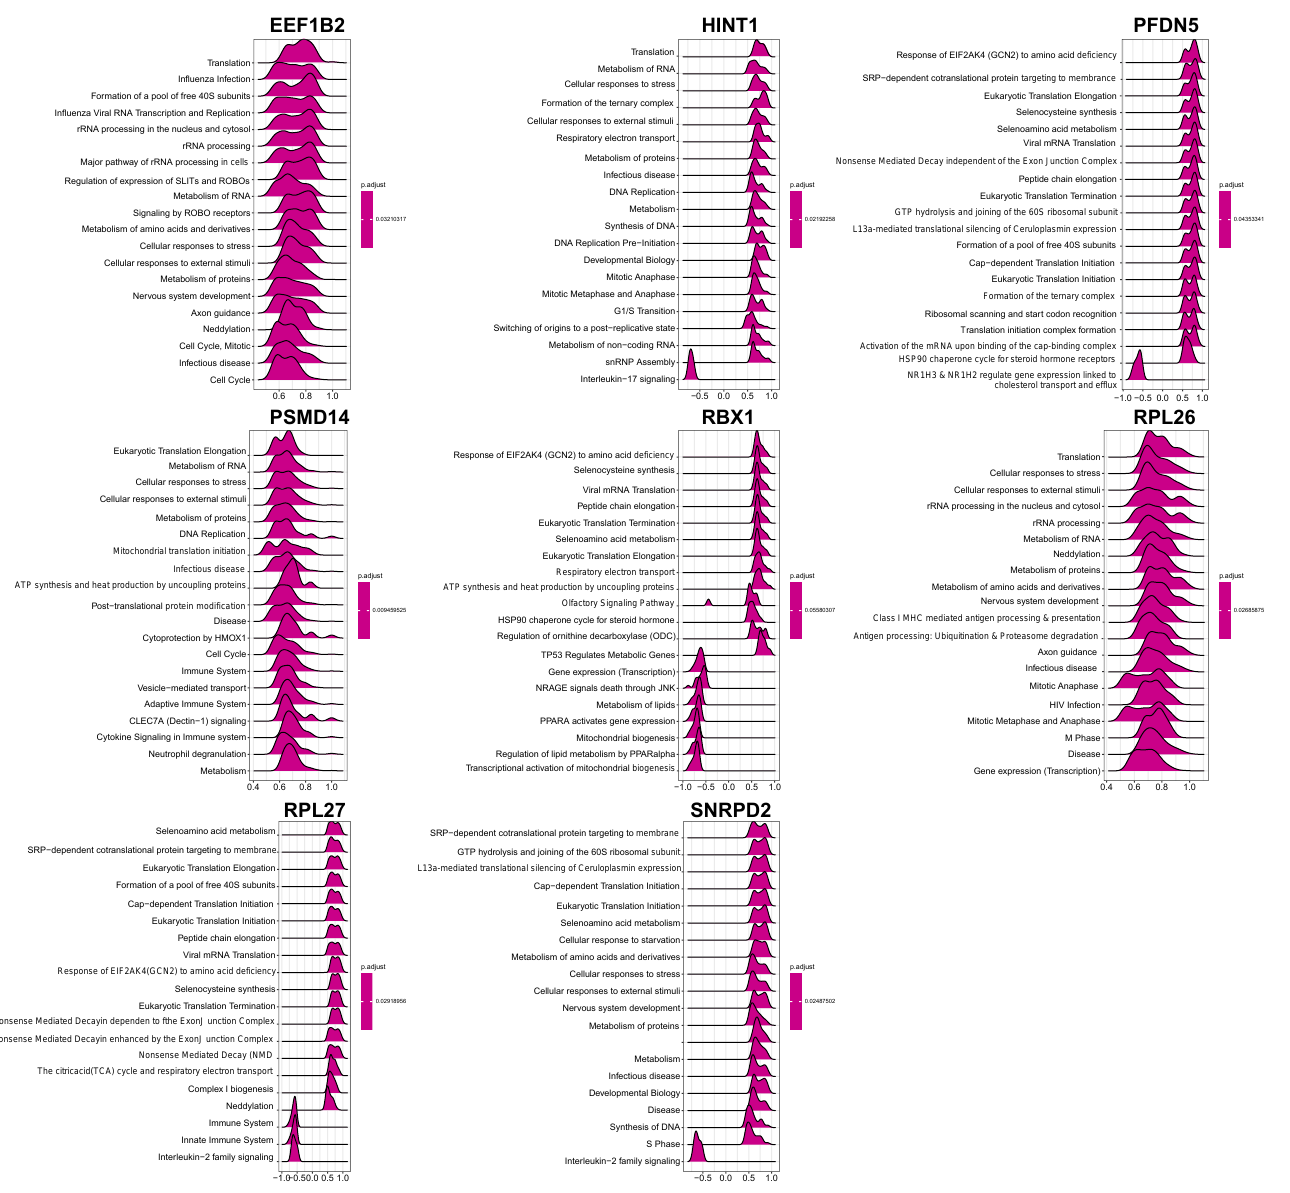
Figure 6. GSEA of the hub genes. The top 20 terms of the GSEA results for the indicated hub genes are